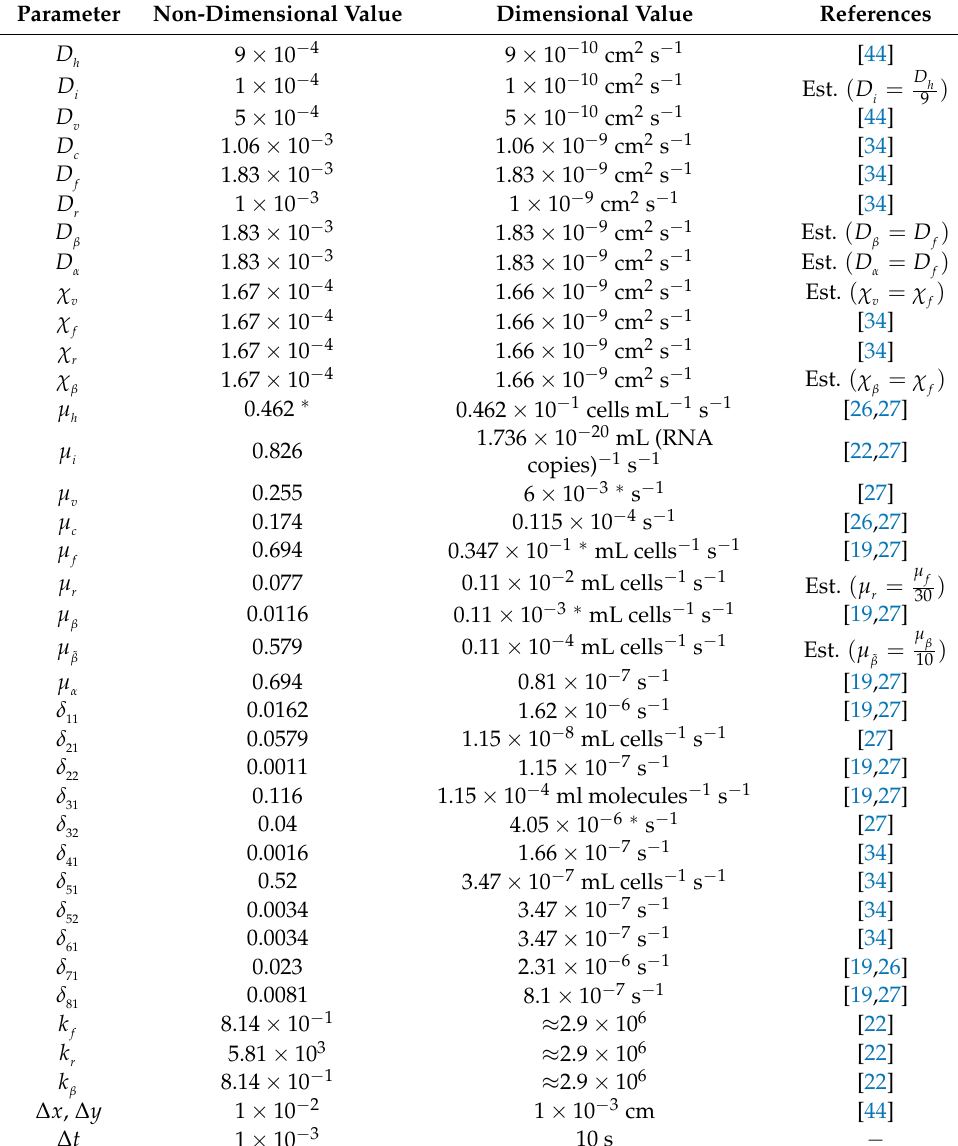
Table 1. Baseline parameters values used in numerical simulations for the spatio-temporal model of COVID-19. ( ∗ ) indicates the modified